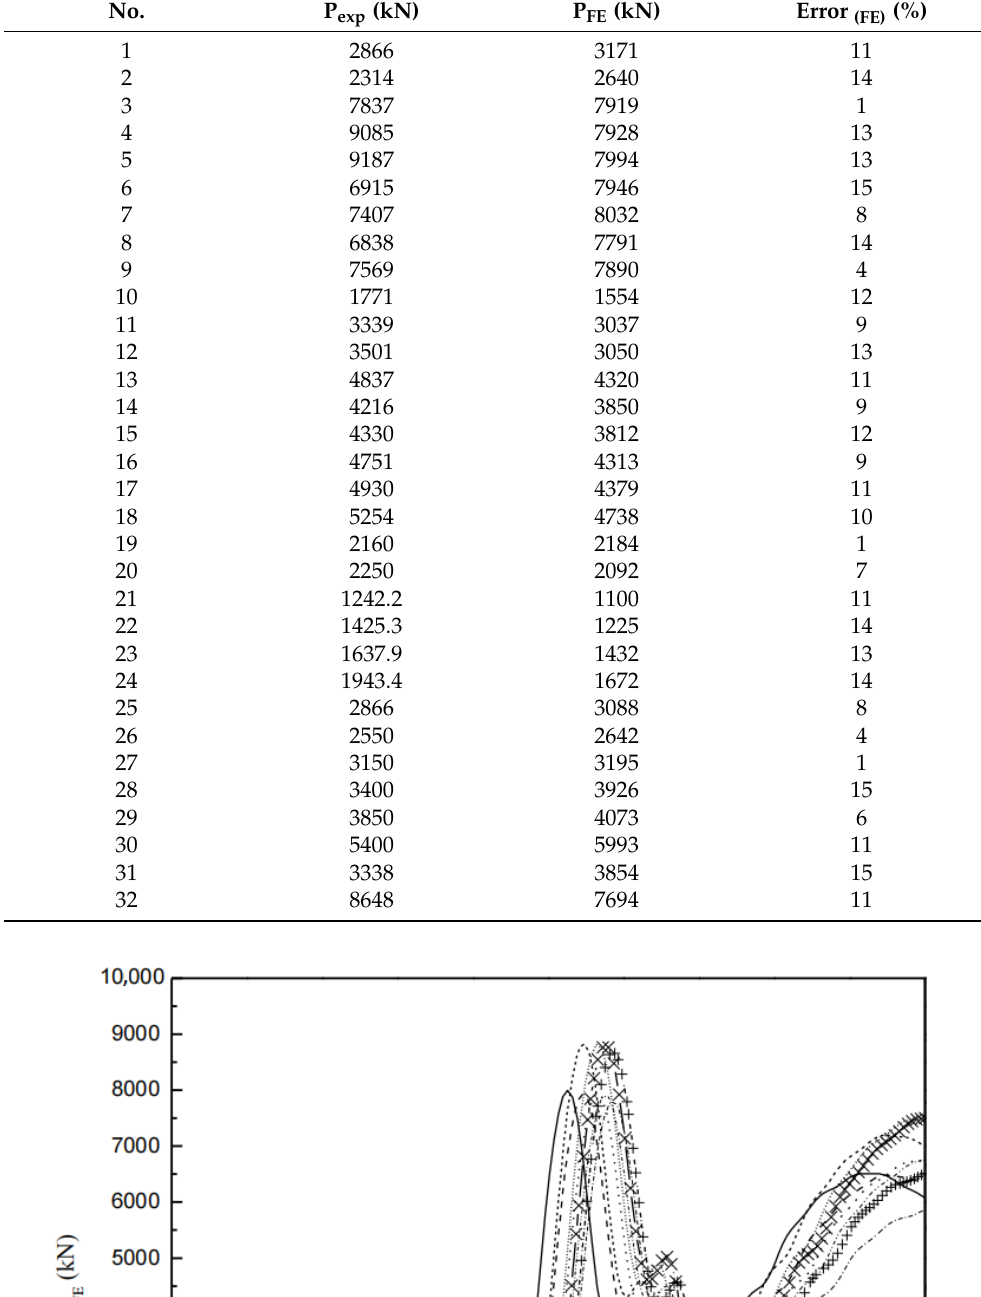
Table 2. Comparison of the experimental results and FE results.